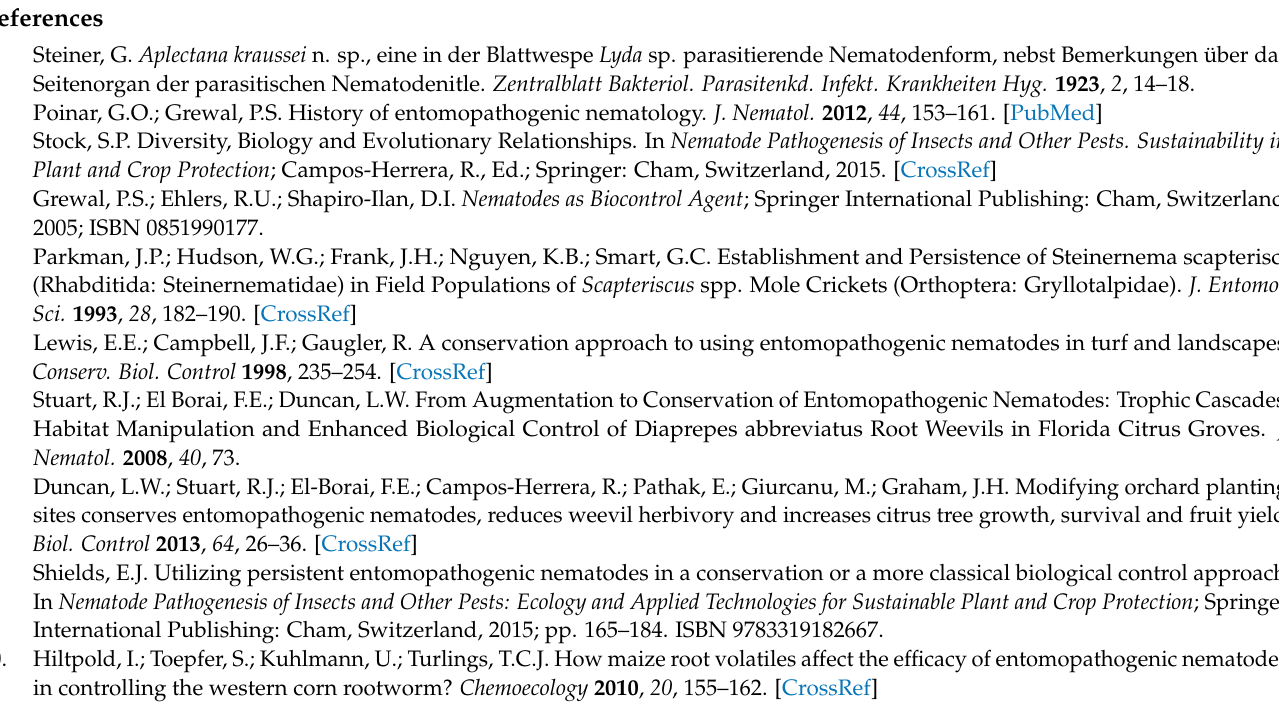
Table S1: NCBI, taxa detection; Table S2: log(natural) total nematodes versus Treatment, sampling Day, replication; Table S3: log(natural) native nematodes versus Treatment, sampling Day,